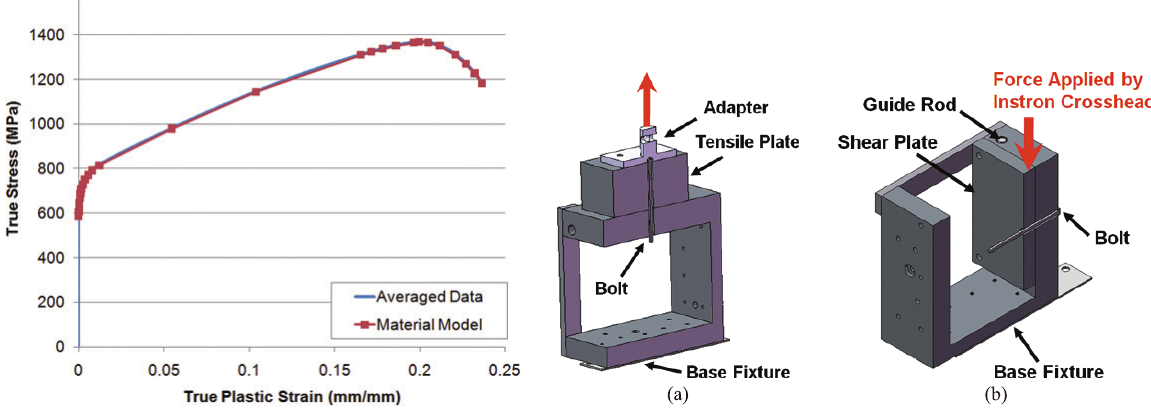
Fig. 1. Constitutive behavior of K-Monel K500 material. Fig. 2. Section view of (a) static tension test; (b) static shear